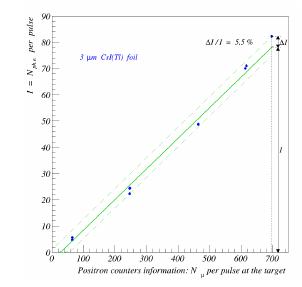
Figure 5. Dependence of sig- nal intensity as function of beam momentum. Horizon- tal bars represent momentum